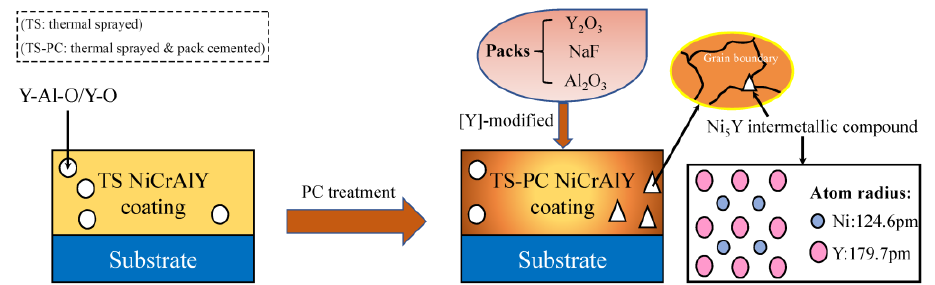
Figure 12. Schematic diagram of Y-modification mechanism.